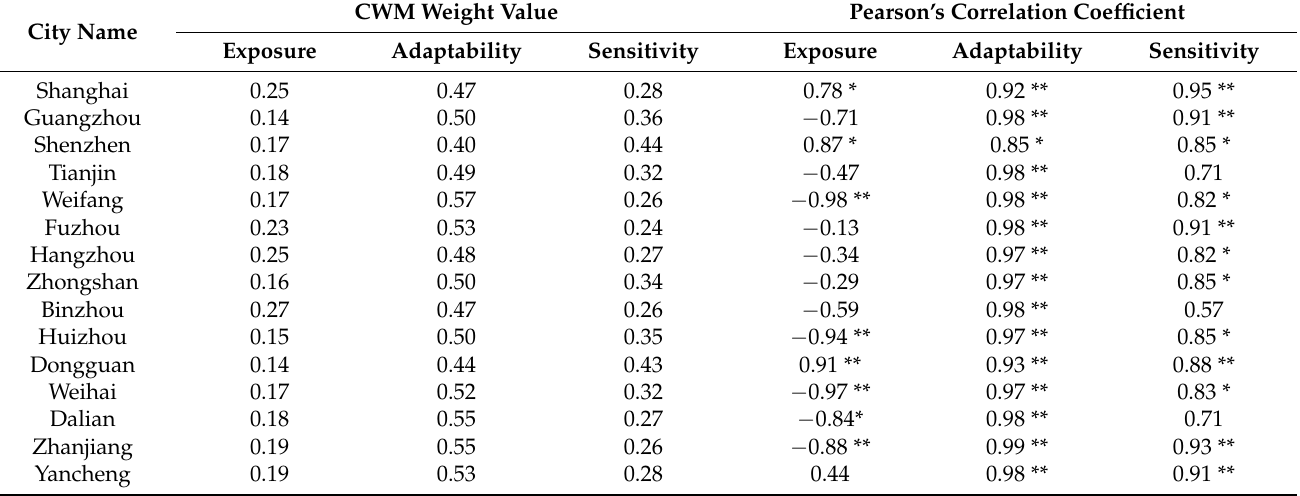
Table 4. Exposure, adaptability, and sensitivity index weights and vulnerability correlation values of 15 coastal